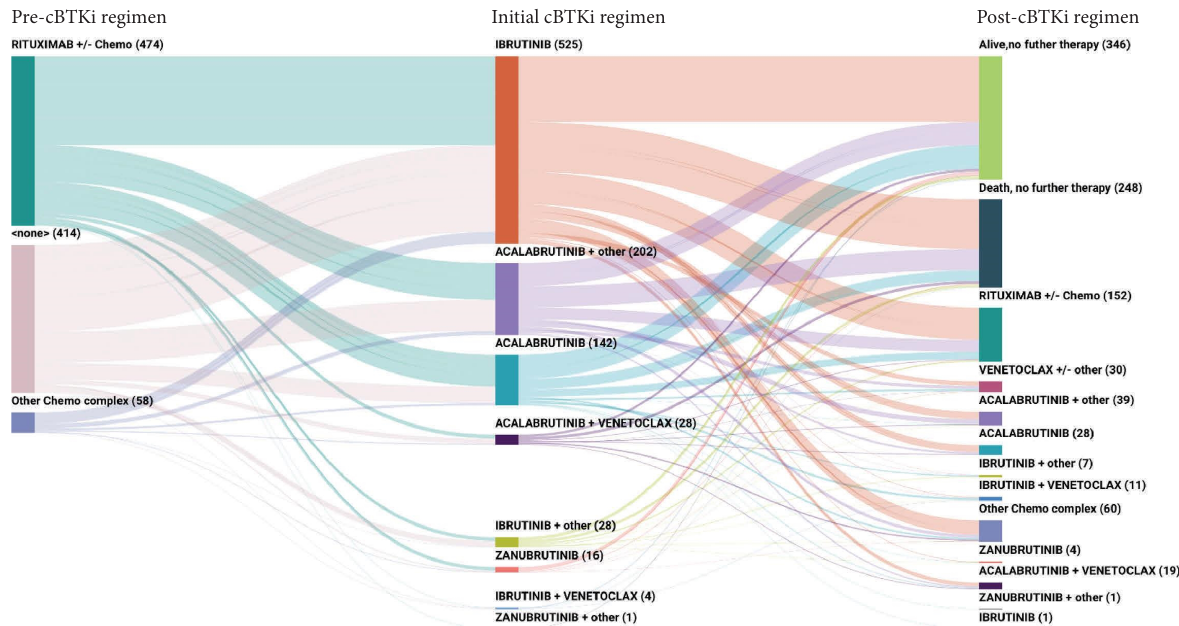
Figure 2: Treatment sequence prior to and following initial cBTKi. Abbreviations: cBTKi � covalent bruton tyrosine kinase